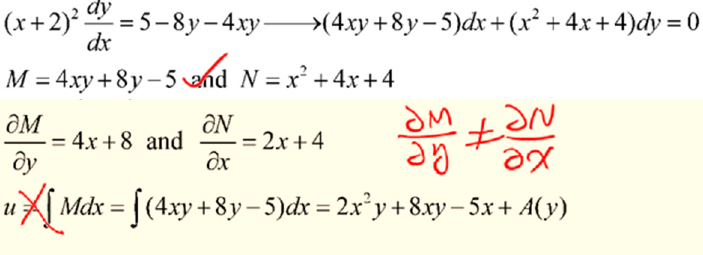
Figure 1. Reproduced example for solving the ODE in Example 2 [yellow indicates the